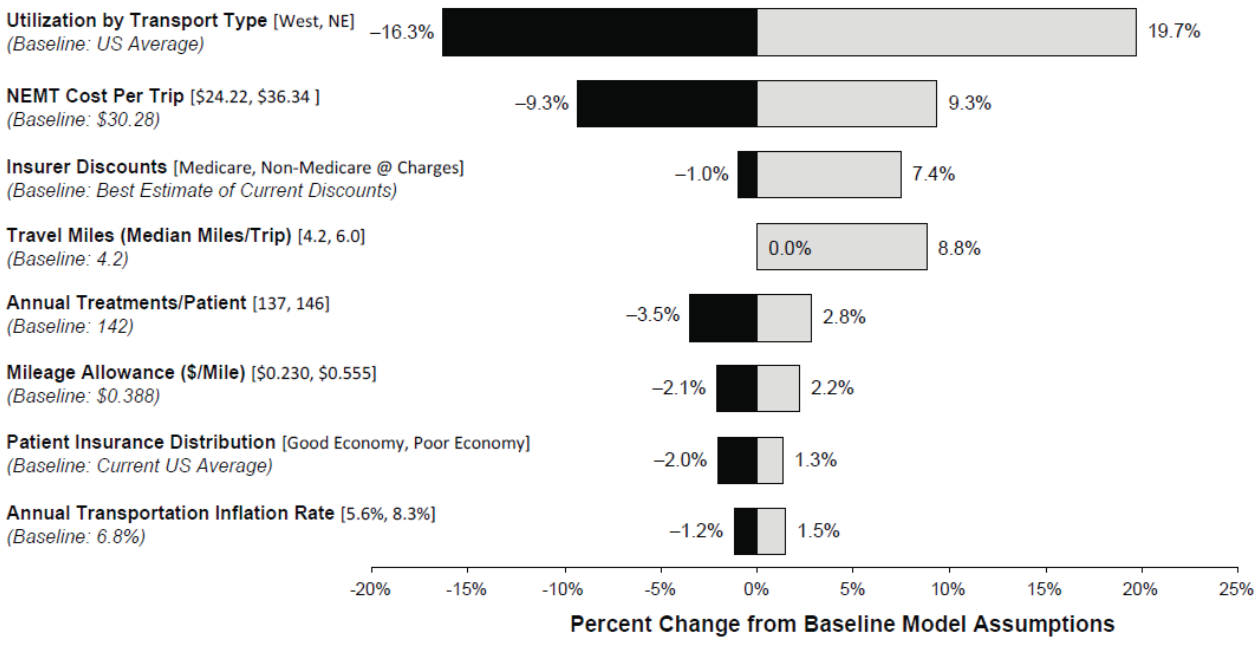
Figure 3. Sensitivity Analysis: Key Factors Influencing Cumulative Dialysis Transportation Costs from 2012 to 2014